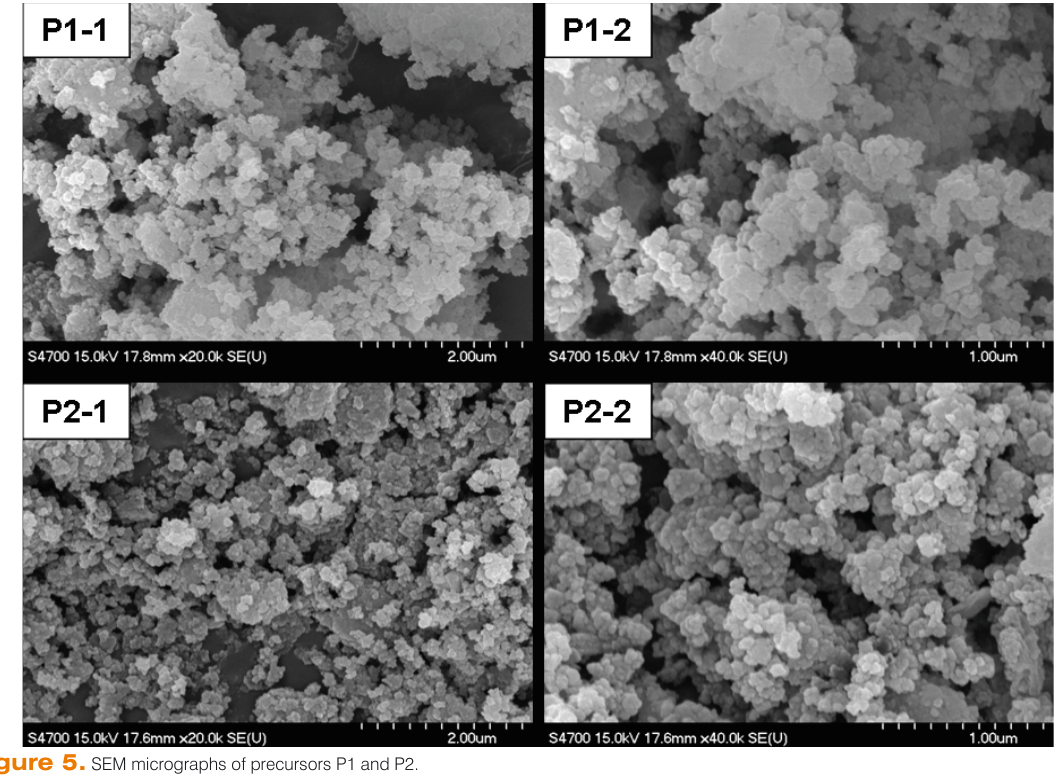
Figure 5. SEM micrographs of precursors P1 and P2.